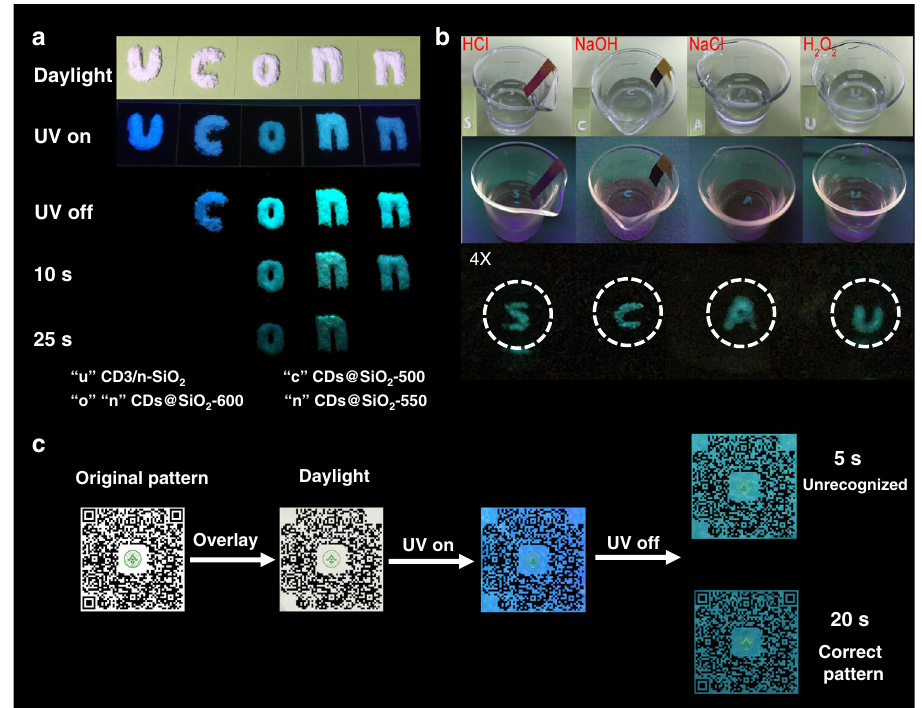
Fig. 6 Time-resolved anti-counterfeiting application of CDs@SiO 2 . a Digital photographs of information encryption made from CDs/n-SiO 2 , CDs@SiO 2 - 500, CDs@SiO 2 -600, and CDs@SiO 2 -550. b Digital photographs of phosphorescence from CDs@SiO 2 -600 in different environmental liquids. c Digital photographs of information encryption made from CDs@SiO 2 -600 and CDs@SiO 2 -550. The white area was overlaid with CDs@SiO 2 -600, and the black part of the corner is covered with CDs@SiO 2